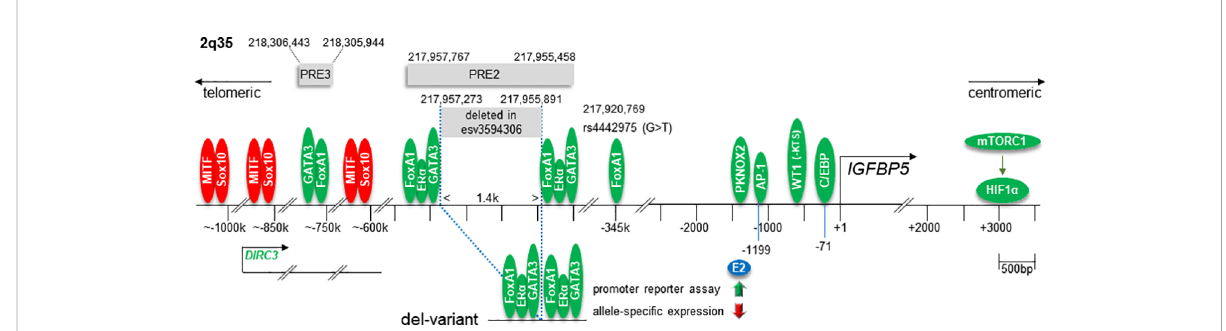
FIGURE 5 Overview of chromosome 2q regions relevant to the transcriptional regulation of the human IGFBP5 gene. These regions include the proximal IGFBP5 promoter, several enhancer elements in the protein-coding gene desert 2q35 and an HIF1 a -binding downstream regulatory element. Numbers above or below the horizontal line indicate the genomic positions or the nucleotide positions relative to the transcriptional start site (+1) of the IGFBP5 gene, respectively. Green ovals indicate stimulatory transcription factors, red ones repressors. The relative position of the gene DIRC3, whose RNA product interferes with MITF and Sox10 activities, and the SNP site rs4442975, which interferes with FoxA1 binding activity, are indicated. In the lower panel, the transcription factor con fi guration in the deletion variant esv3594306 and its consequences for the estrogen (E2) response, as measured by promoter reporter or by allele-speci fi c expression assays, are shown. PRE, putative regulatory